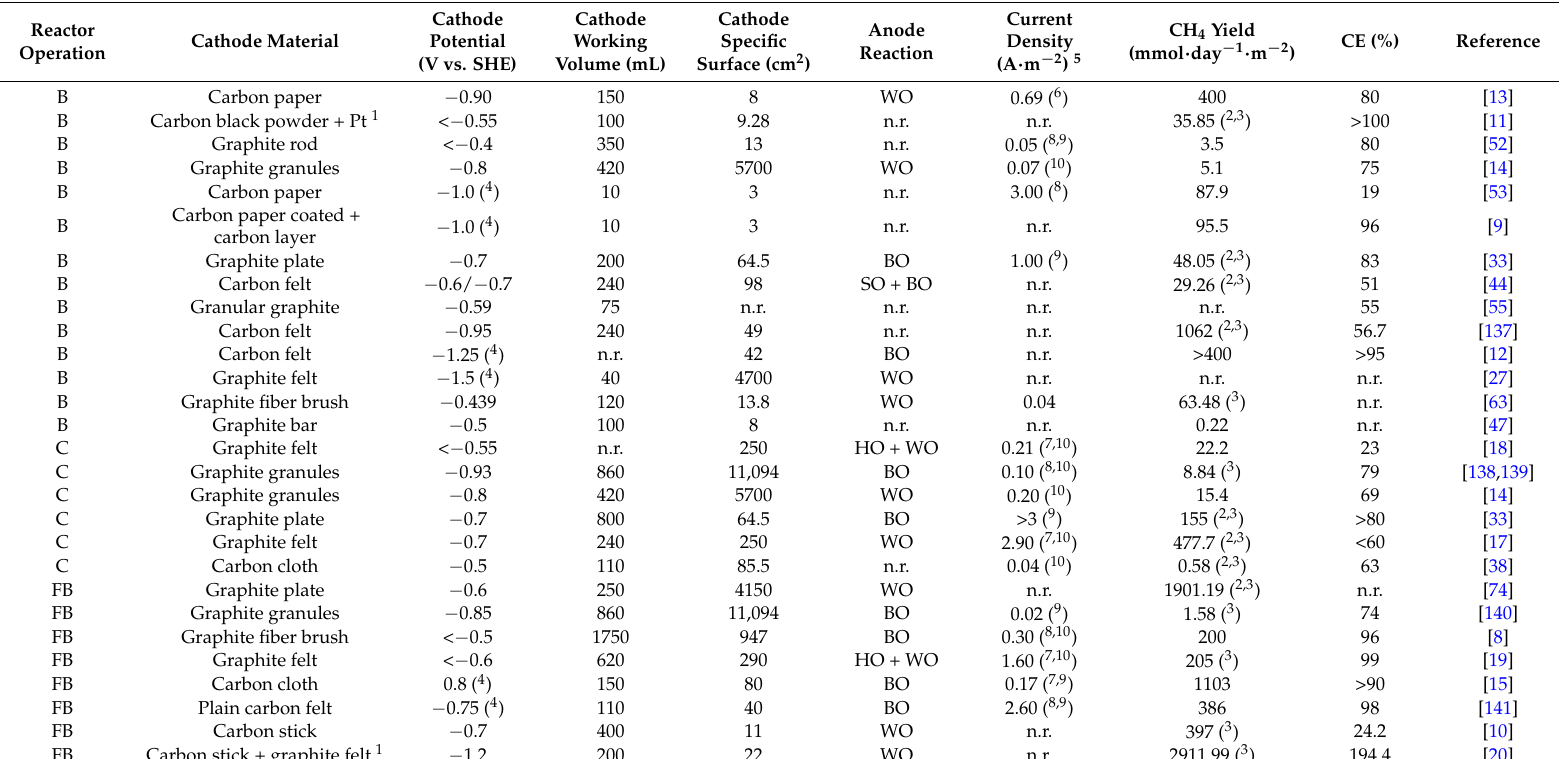
Table 2. Overview of the operational parameters and performance of methane-producing